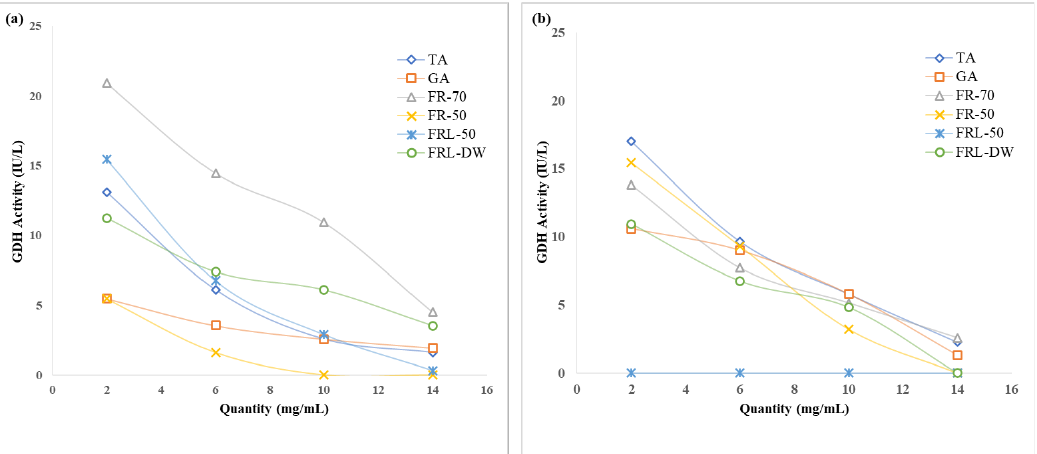
Figure 2. The effect of different proanthocyanin extracts. TA: Tannic acid, GA: Gallic acid, FRL-50: